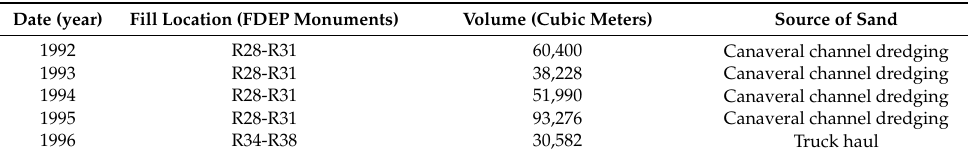
Table 1. Cocoa beach fill